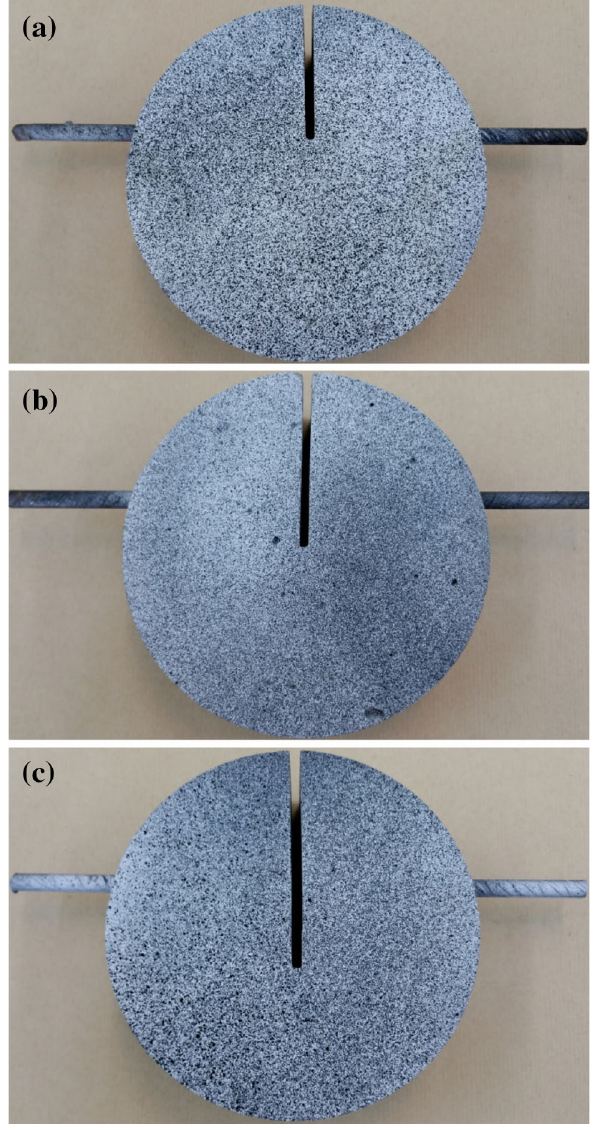
Fig. 6 Final outlook of the MDCT specimens for different notch depths: a a = 0.1, b a = 0.3 and c a = 0.5.